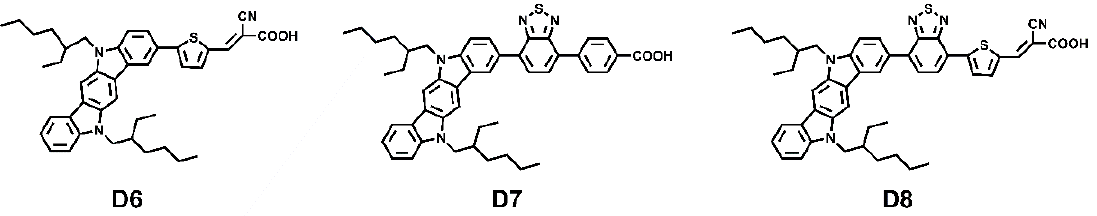
Figure 1. The structures of the new dyes.